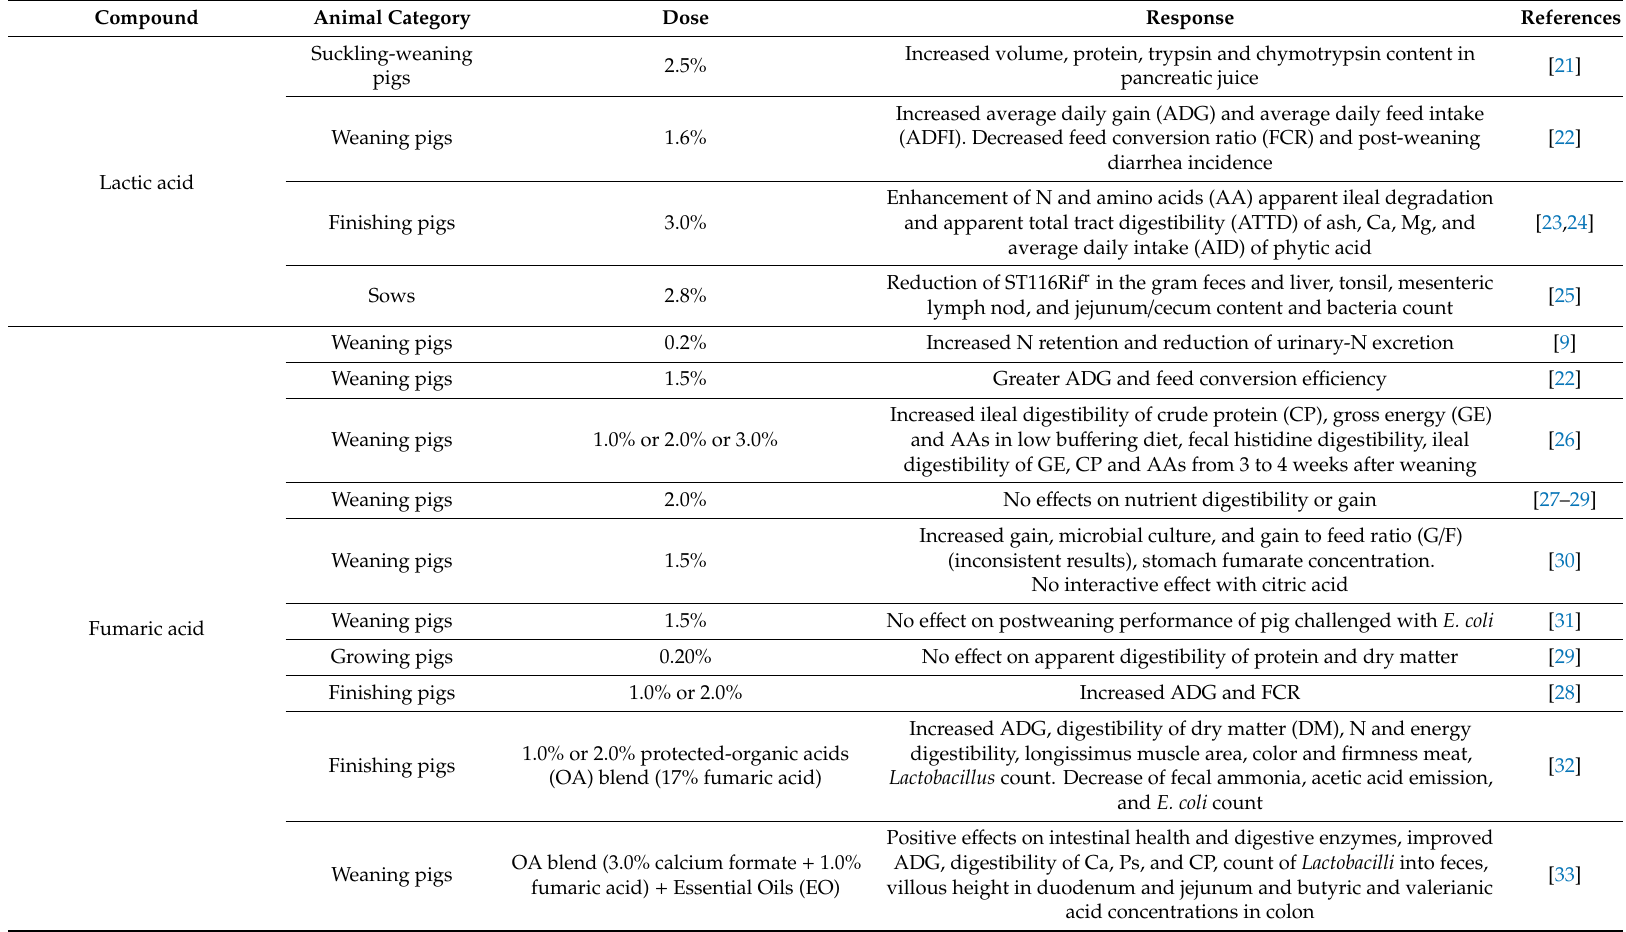
Table 2. Summary of studies about the most common organic acids used in pig